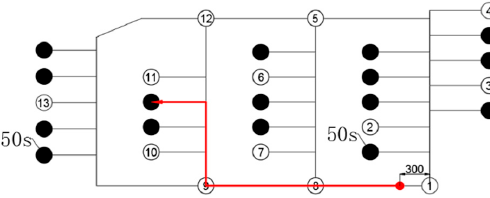
Figure 10. Real-time condition 2 of the parking lot.